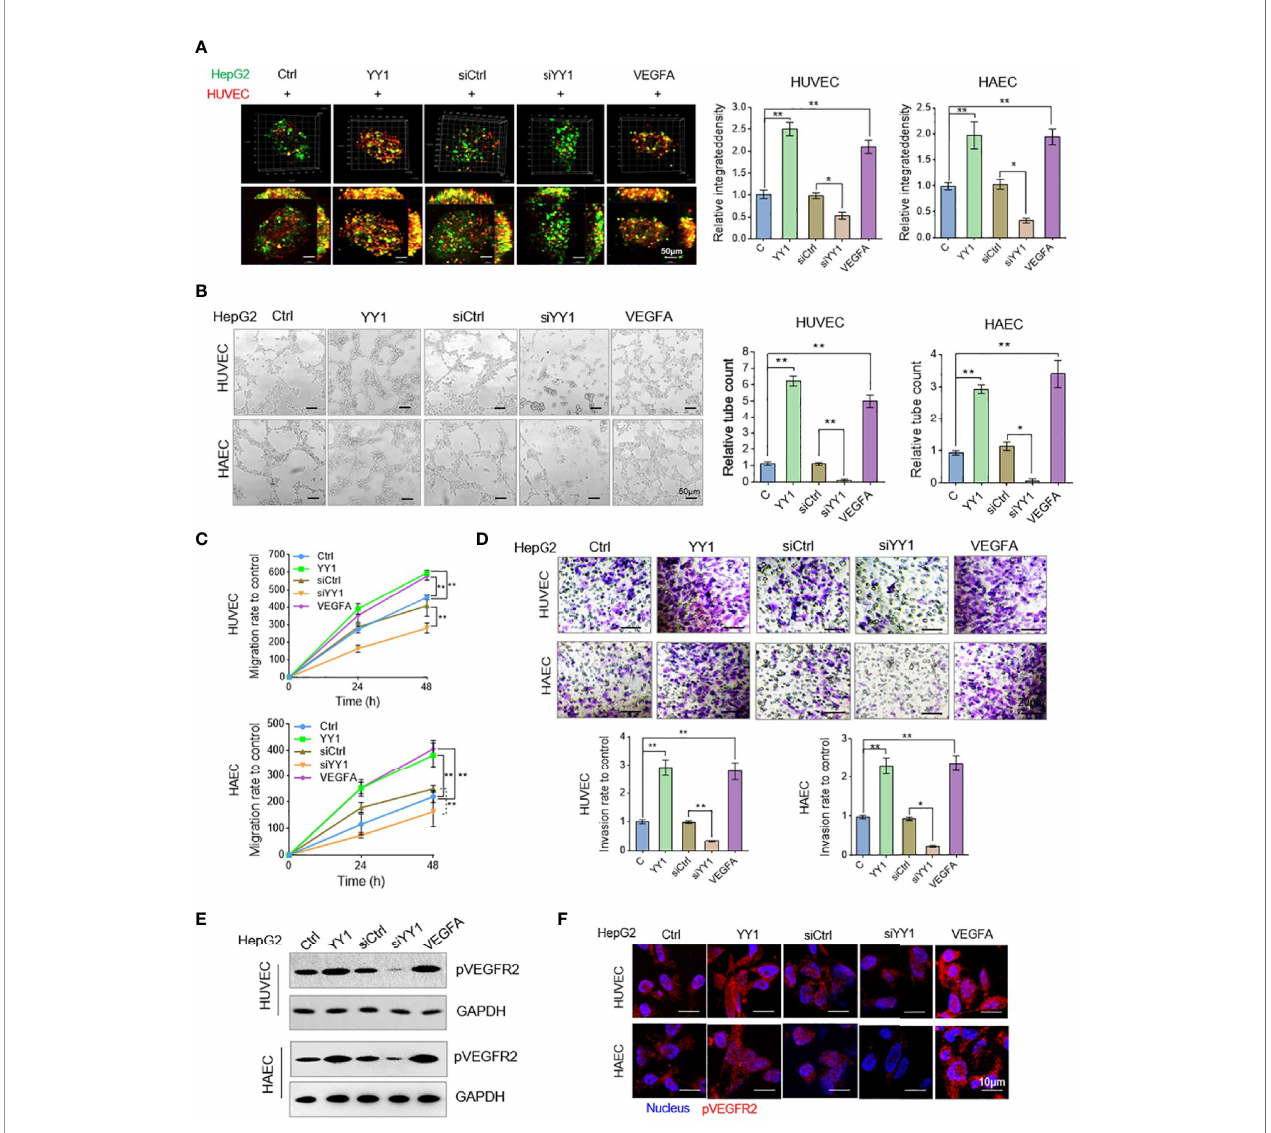
FIGURE 4 | YY1 stimulated HCC cell culture media accelerated endothelial cells neovascularization. (A) HUVECs and HAECs (red) and HepG2 cells (green) co-cultured in a 1:2 ratio and formed three-dimensional spheroids. Images were taken with a laser scanning confocal microscope, scale bar = 50 m m. (B) Representative image (left) of the formation of HUVECs and HAECs tubes following an incubation with supernatants collected from the indicated cells. Tube formation quanti fi cation were analyzed (right). Scale bar = 50 m m. (C) HUVECs and HAECs migration were detected after an incubation with supernatants collected from the indicated cells. (D) HUVECs and HAECs invasion were detected following an incubation with supernatants collected from the indicated cells. Scale bar = 20 m m. (E) WB analyzed pVEGFR2 expression in HUVECs and HAECs treated with conditioned media. (F) Immuno fl uorescence of pVEGFR2 expression in HUVECs and HAECs treated with conditioned media. Scale bar = 10 m m. * P < 0.05, ** P <